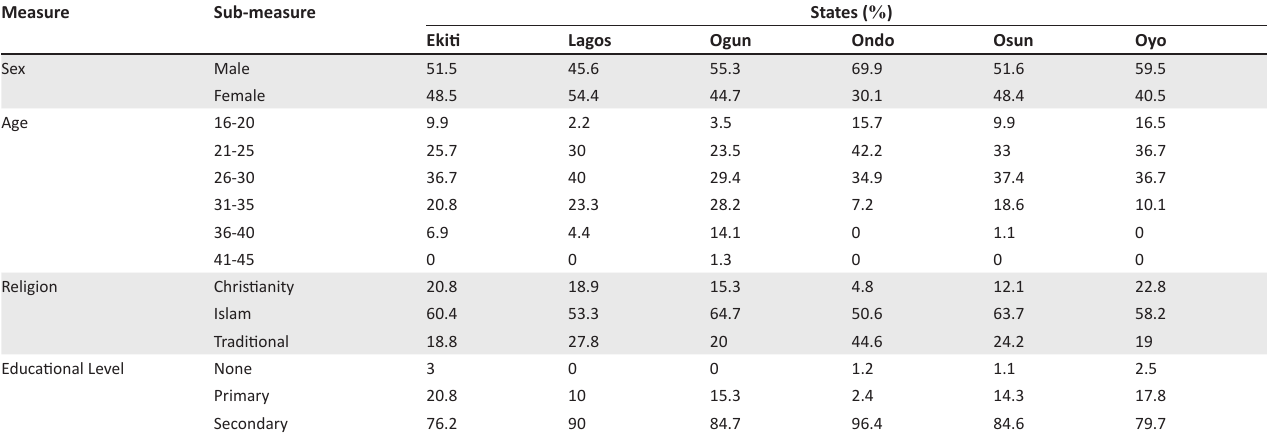
TABLE 2: Demographic distribution of apprentices by state. Measure